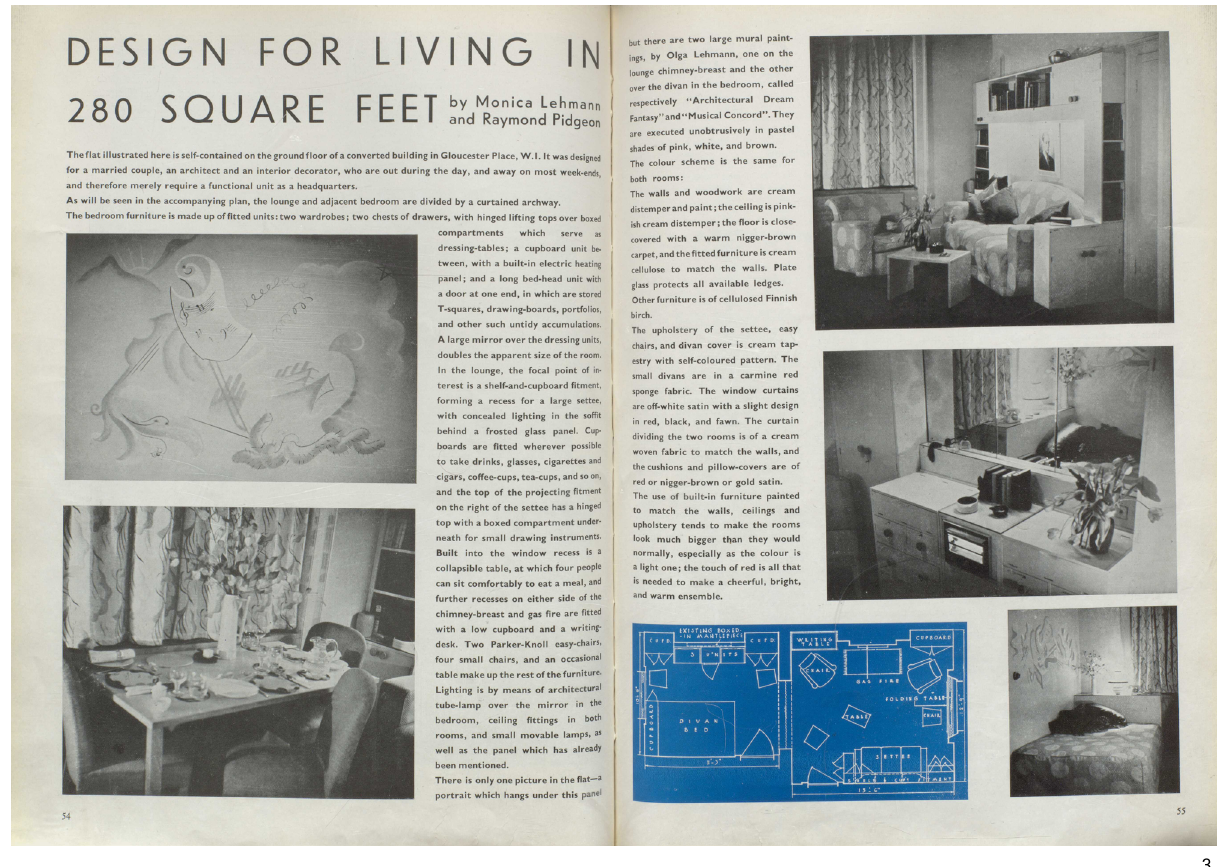
Monica and Raymond’s flat published in